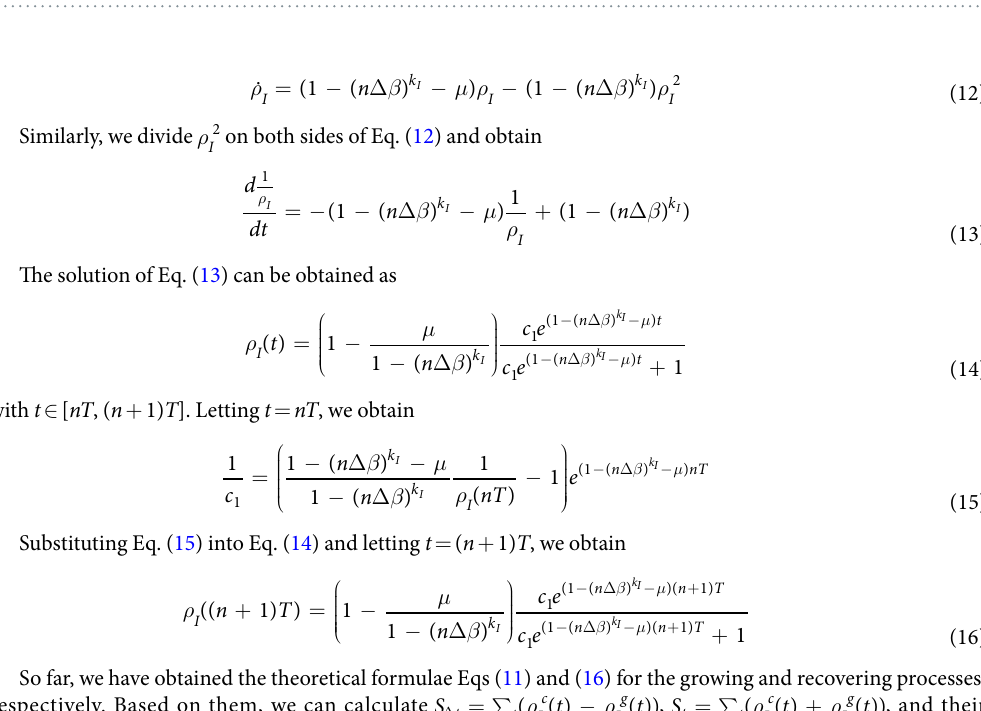
dependence on the two key parameters Δ β and T . The solid lines in Fig. 8(a–d) show the corresponding theoret- ical results, respectively. For comparison, we also put their corresponding numerical simulations, see the “squares”. We see that they are consistent with each other very well, indicating that the numerical results can be explained by the mean-field theory.